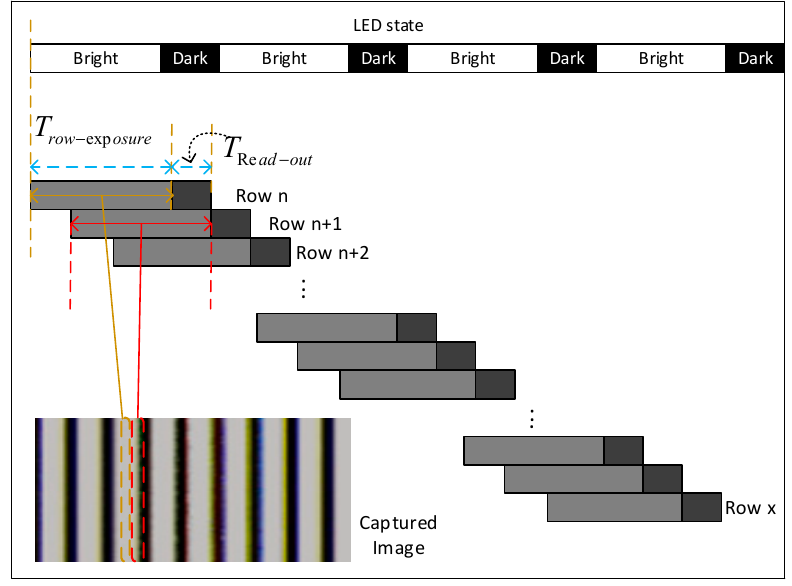
Figure 3. LED image capturing mechanisms for a rolling shutter camera [7].